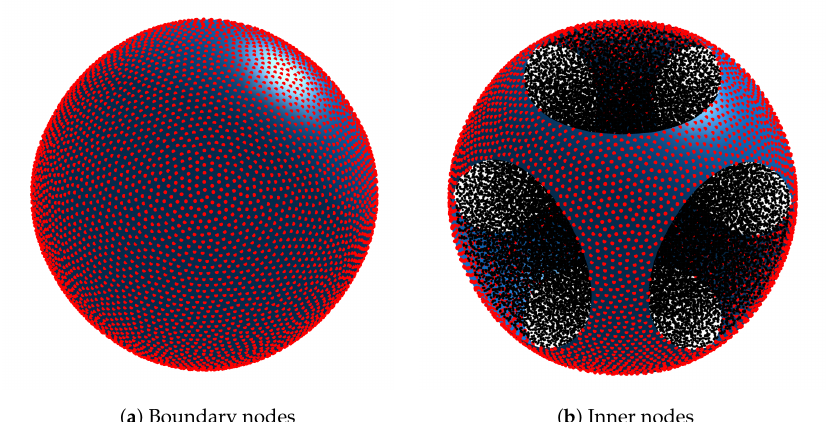
Figure 2. Example of node distribution with N ≈ 50k nodes in the sphere: boundary nodes are represented in red, inner nodes in